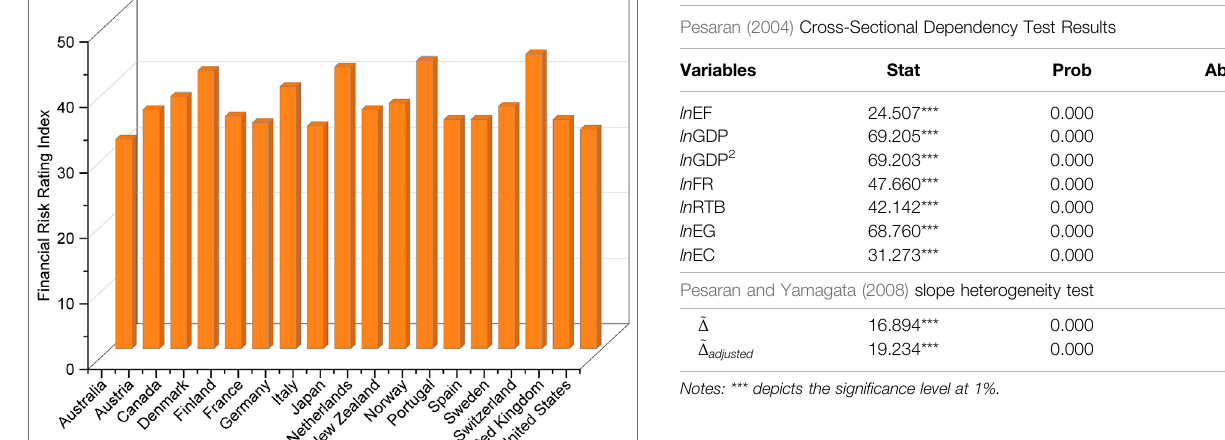
TABLE 4 | Cross-sectional dependency and slope homogeneity